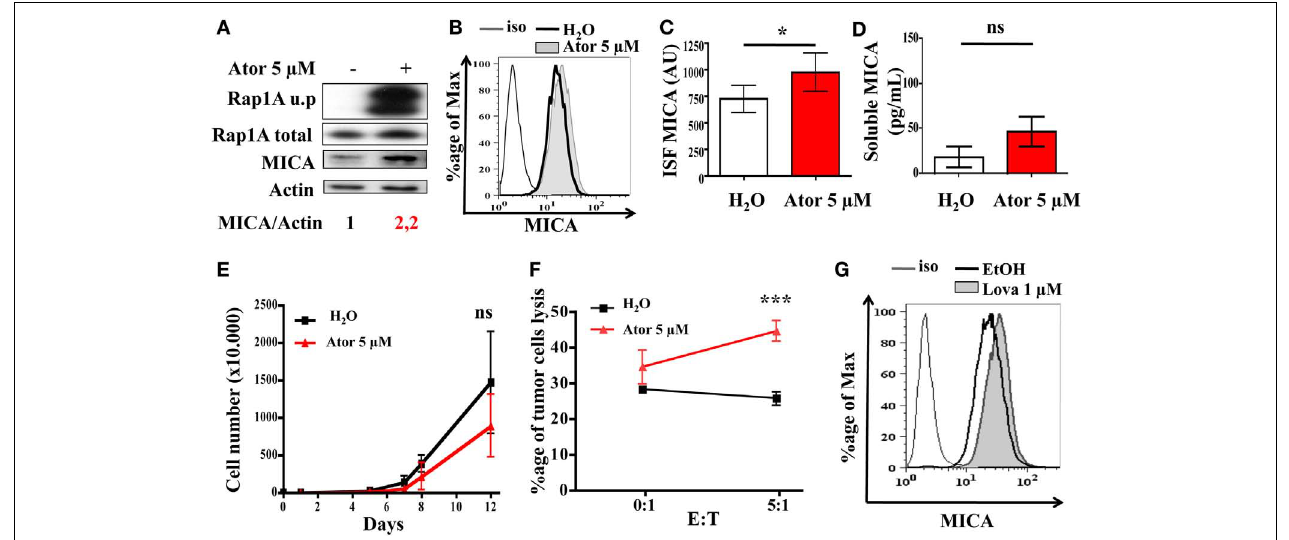
control condition using the Student t -test. Every 2–3days pretreated (Ator) and untreated (H 2 O) LB1319-MEL cells were counted to evaluate the in vitro proliferation (E) . ns; versus control condition using the two-way ANOVA test. Percentage of lysed LB1319-MEL cells pretreated (Ator) or untreated (H 2 O) after coculture with murine NK cells was evaluated with Cytoxilux kit (Onco-immumin, Interchim). Murine NK cells were first isolated from